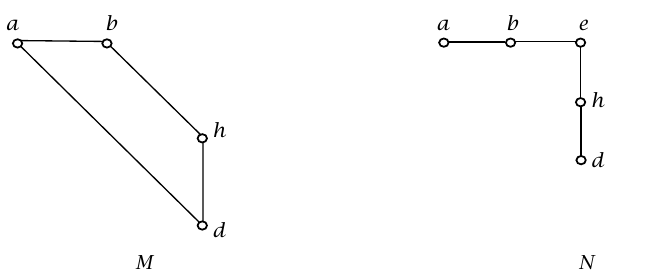
Figure 2.1 . The converse of Proposition 2.5 does not